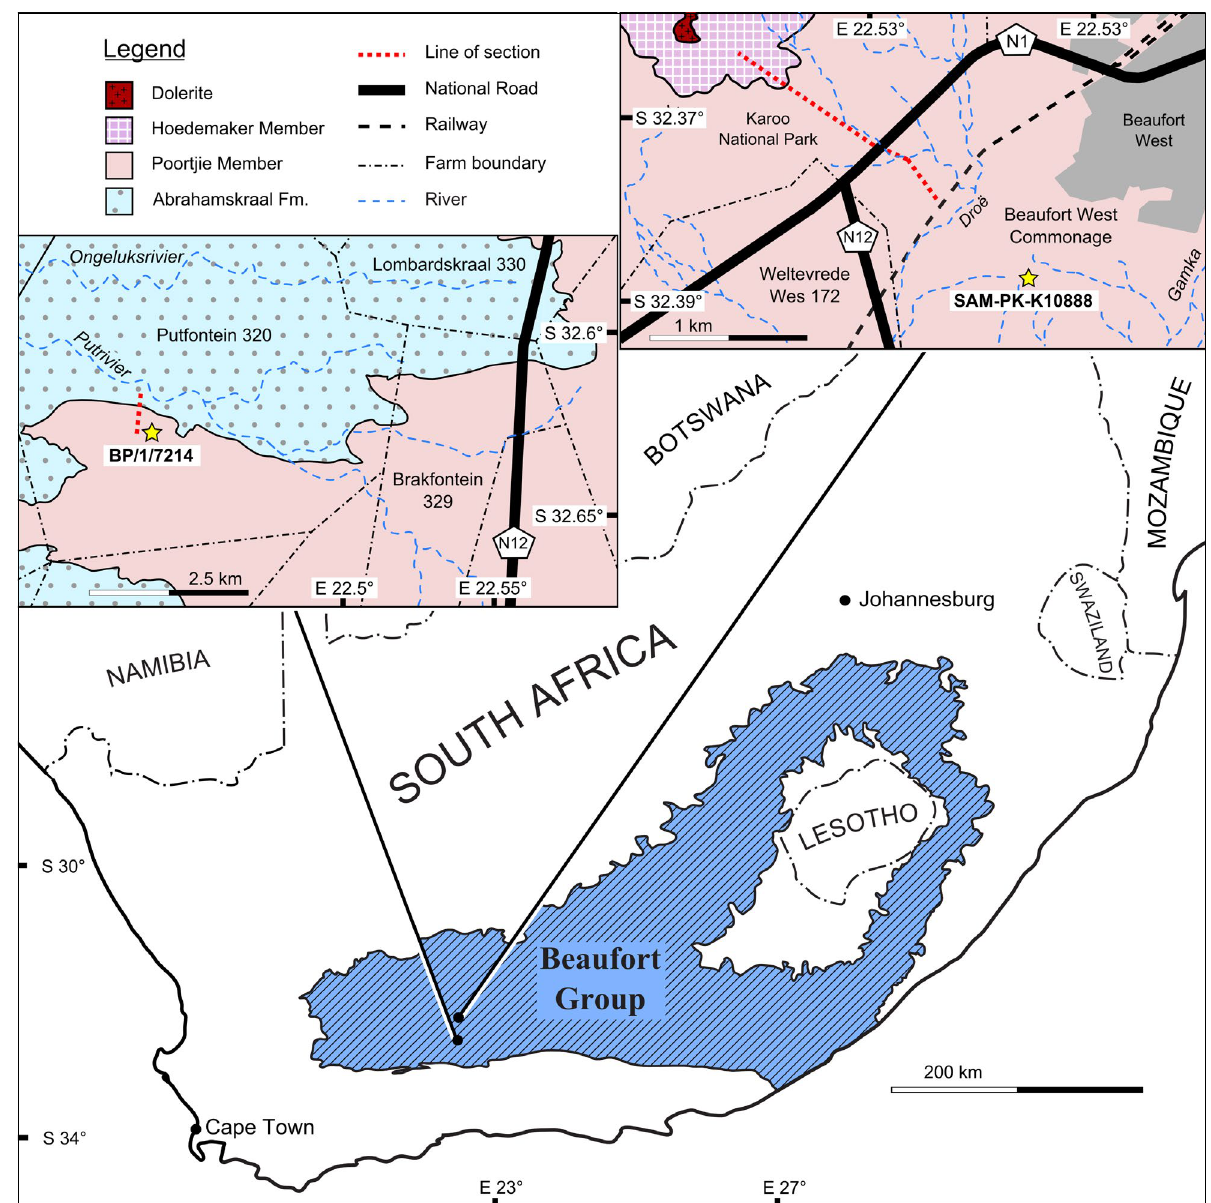
Figure 1: Map of the southwestern Karoo Basin, showing the localities of SAM-PK-K10888 and BP/1/7214 and the line of sections presented in Figure 2.